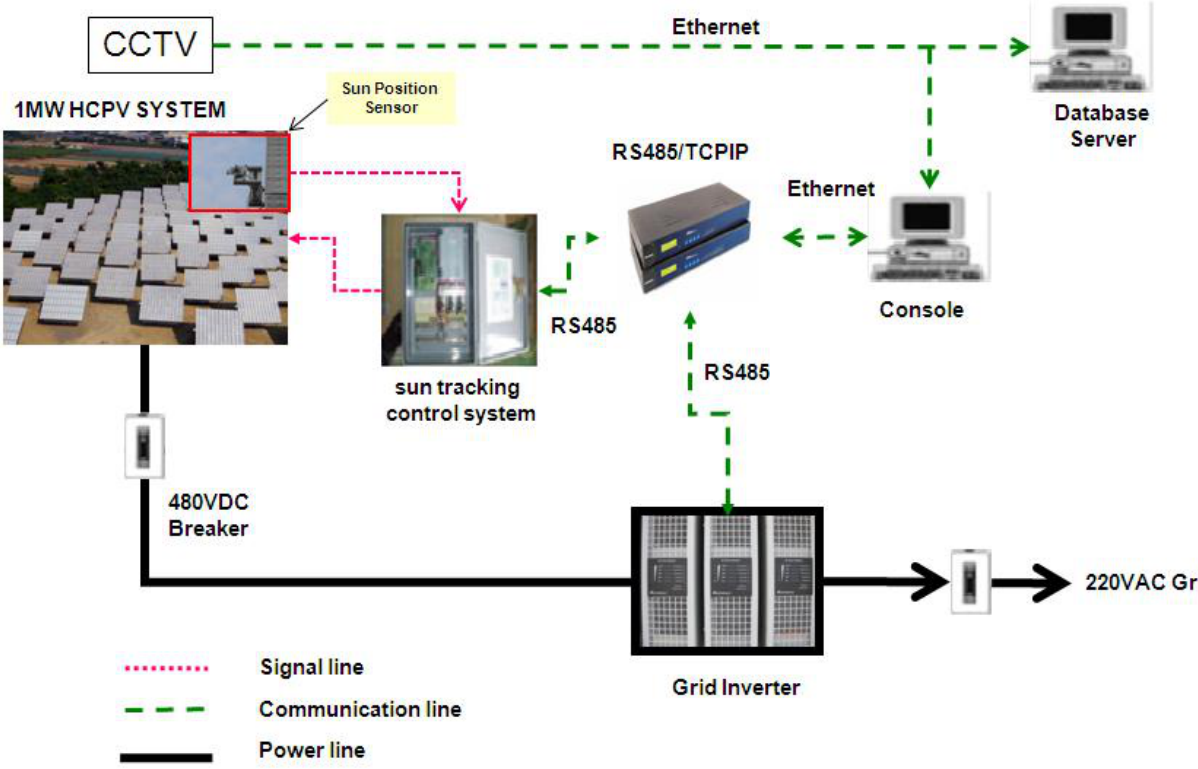
Figure 1. One MW High concentration photovoltaics (HCPV) demonstration power plant system